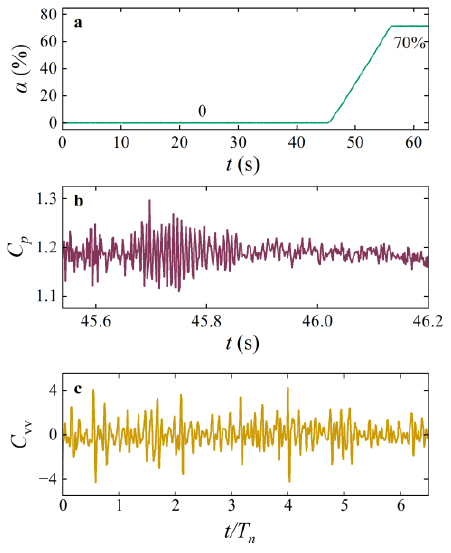
Figure 18. Time histories of Main operating parameters in site test 1. ( a ) GV opening angle after the ball valve starts to open; ( b ) static pressure coefficient in vaneless space within a GV opening range of 0 to 5%; ( c ) α = 0.2° for GV-M horizontal vibration velocities of the guide vane blade within a GV opening range of 0 to 5%.